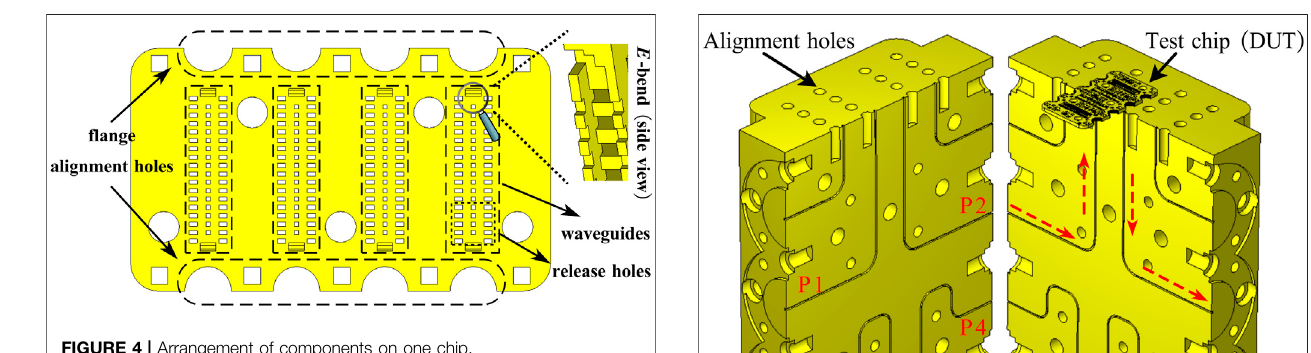
FIGURE 4 | Arrangement of components on one chip.